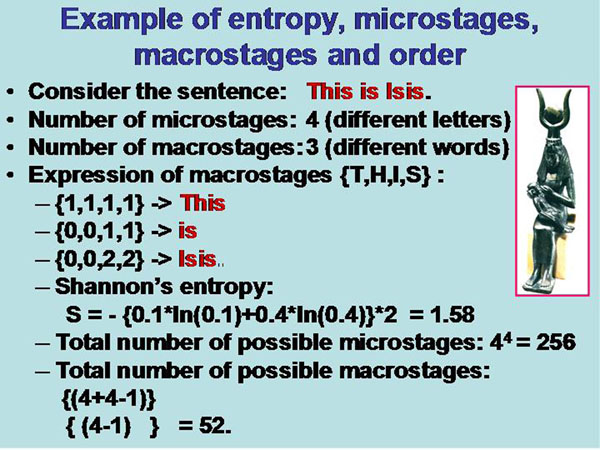
Calculation of entropy, micro and macrostages of the sentence /This is Isis/